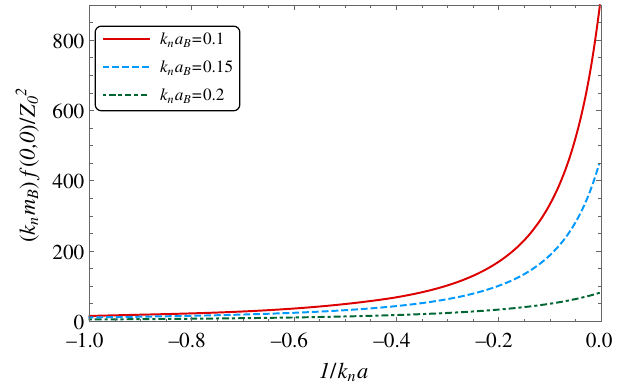
FIG. 8. The Landau effective interaction f ð 0 ; 0 Þ as a function of 1 =k a for a vanishing impurity concentration, zero temperature, n ¼ 40 = 7 , and various boson-boson interaction mass ratio m=m B